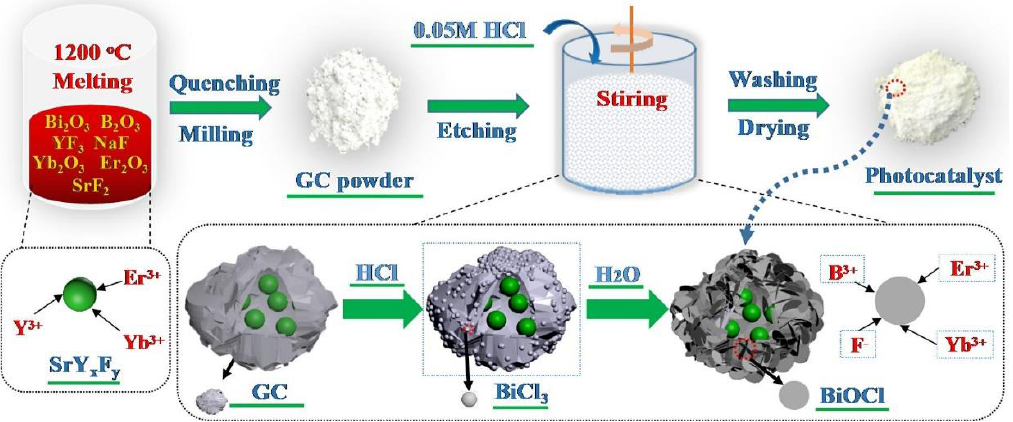
Figure 17. Schematic illustration for the preparation of GCs and photocatalyst. Reprinted with permission from Ref. [123].